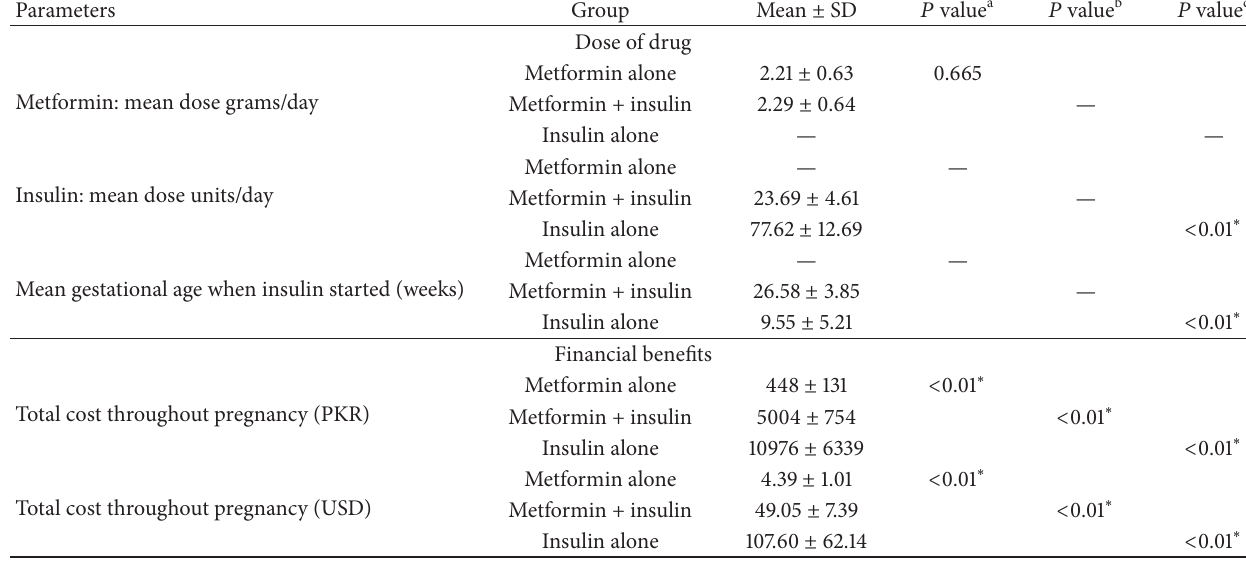
Table 4: Pharmacotherapeutic characteristics in treatment groups ( 𝑛 = 206